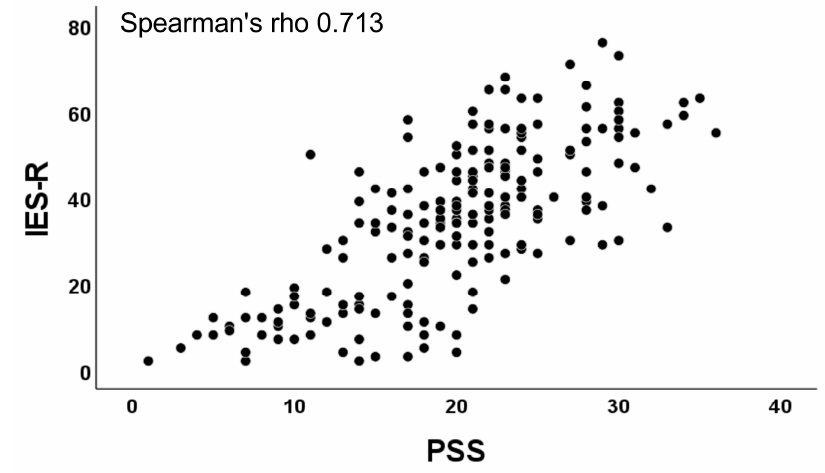
Figure 1. Correlation between PSS and IES-R scores.